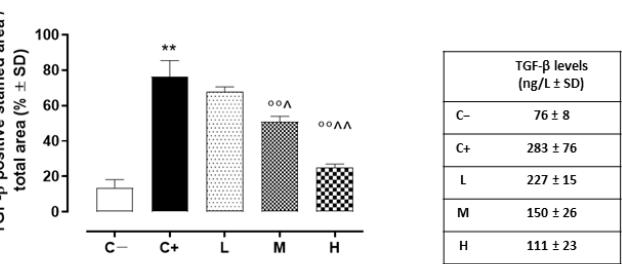
Figure 8. Corneal TGF- β levels (ng/L ± SD) in the TSP-1 KO mice euthanized at 6 weeks of age as a negative control for SS-associated dry eye (C − ); TSP-1 KO mice euthanized at 12 weeks of age as a positive control for SS-associated dry eye (C+); and TSP-1 KO mice supplied with low (L), medium (M), and high (H) doses of vitamin D3 (1000, 8000, and 20,000 IU/kg/week, respectively) from week 6 to week 12 of age. N = 5 corneas per group. ** p < 0.01 vs. C − ; ◦◦ p < 0.01 vs. C+; ˆ p < 0.05 and ˆˆ p < 0.01 vs. L.